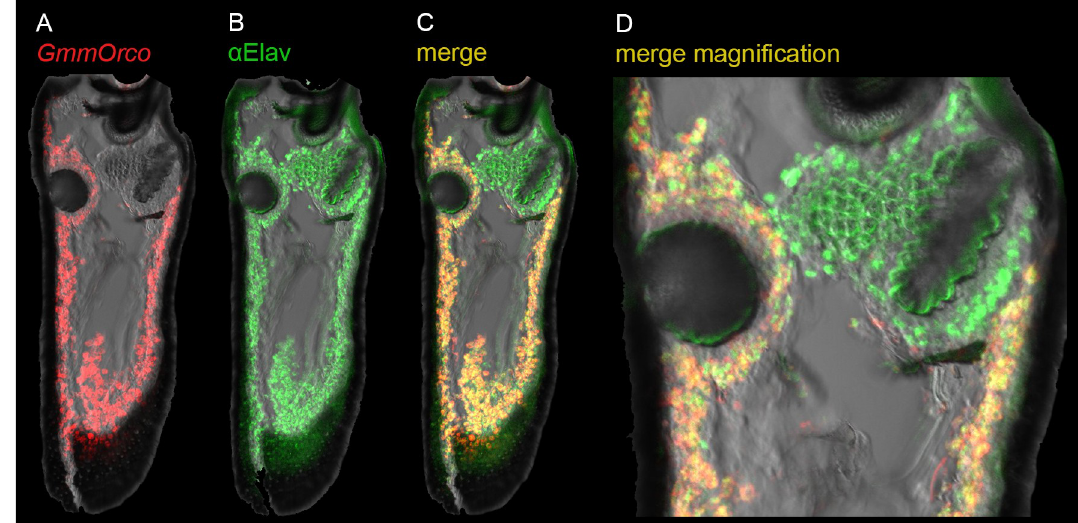
Fig 4. Expression of GmmOrco in the antenna. (A) In situ hybridization to GmmOrco (red). (B) Immunostaining of pan-neuronal marker Elav (green). (C) Merged image of GmmOrco and anti-E lav. (D) Magnification of (C).